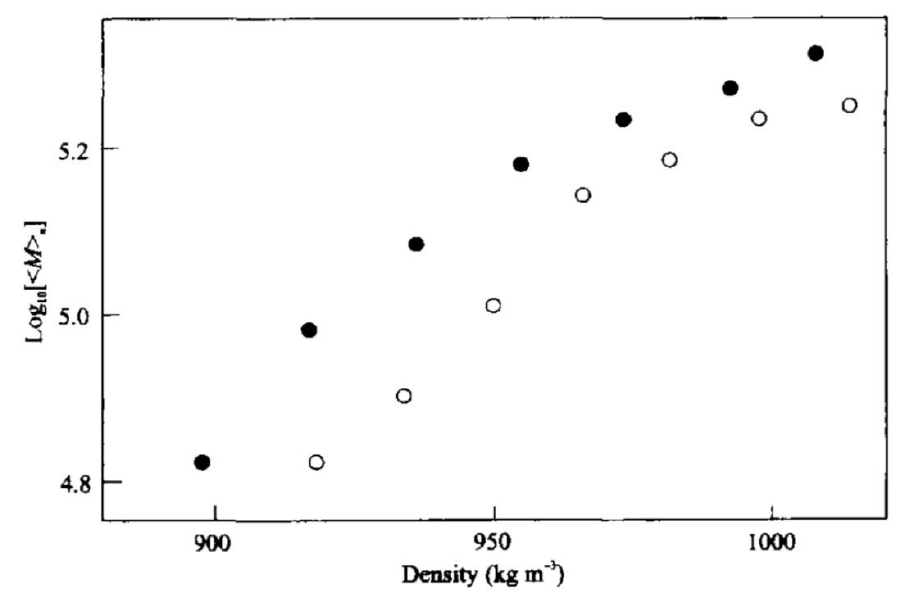
Figure 7. Supercritical extraction of polydimethylsiloxane using a linear density program; the graph shows the logarithm of the number-averaged molar masses of the fractions versus fluid density with filled circles (●) for a lower rate of density increase and open circles ( ○ ) for a higher rate. Reproduced from Ref. [91], Copyright (1997), with permission from Elsevier.